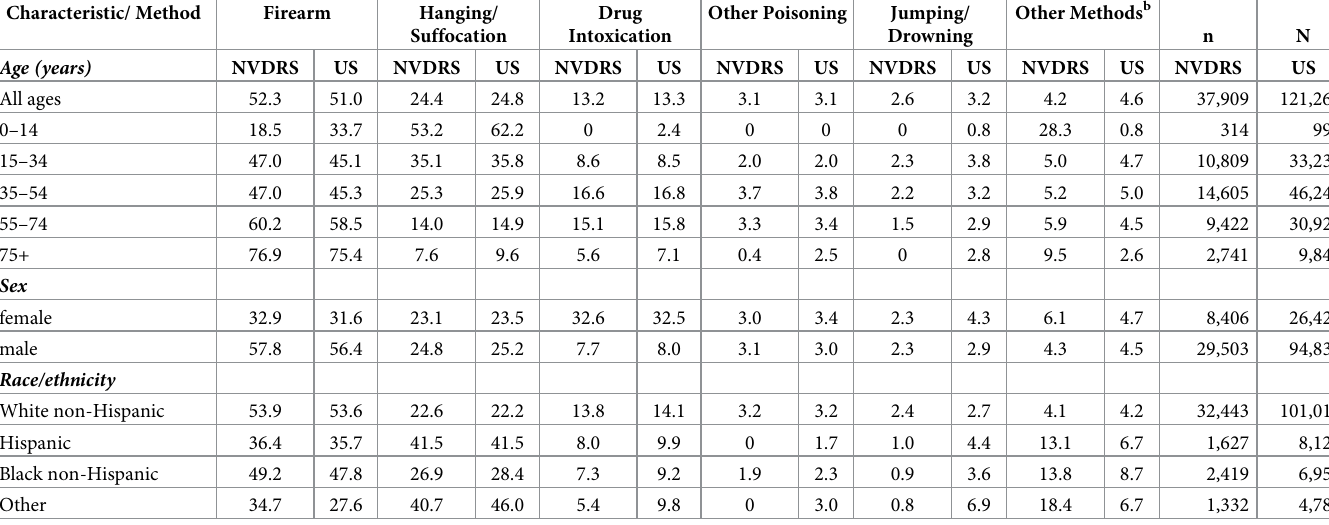
Table 1. Percent suicide by method and selected demographic characteristics: 17 National Violent Death Reporting System States and the United States, 2011– 2013 a . Characteristic/